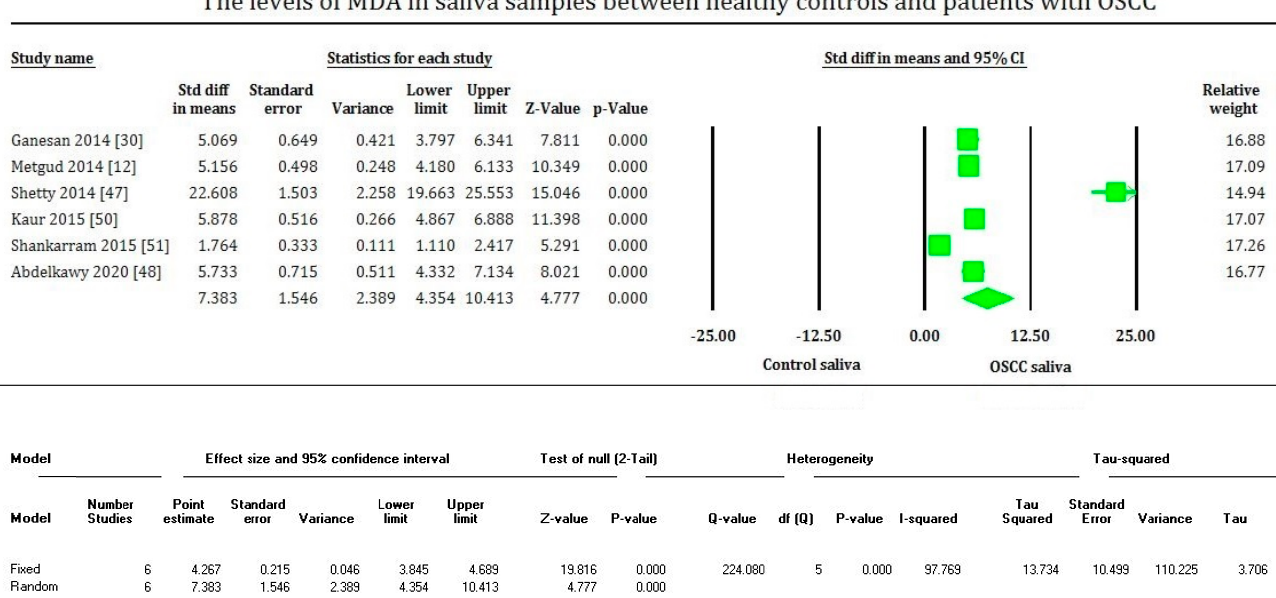
Figure 4. Forest plot shows mean difference estimates with 95% confidence intervals representing differences in salivary levels of MDA between oral squamous cell carcinoma group and healthy controls.